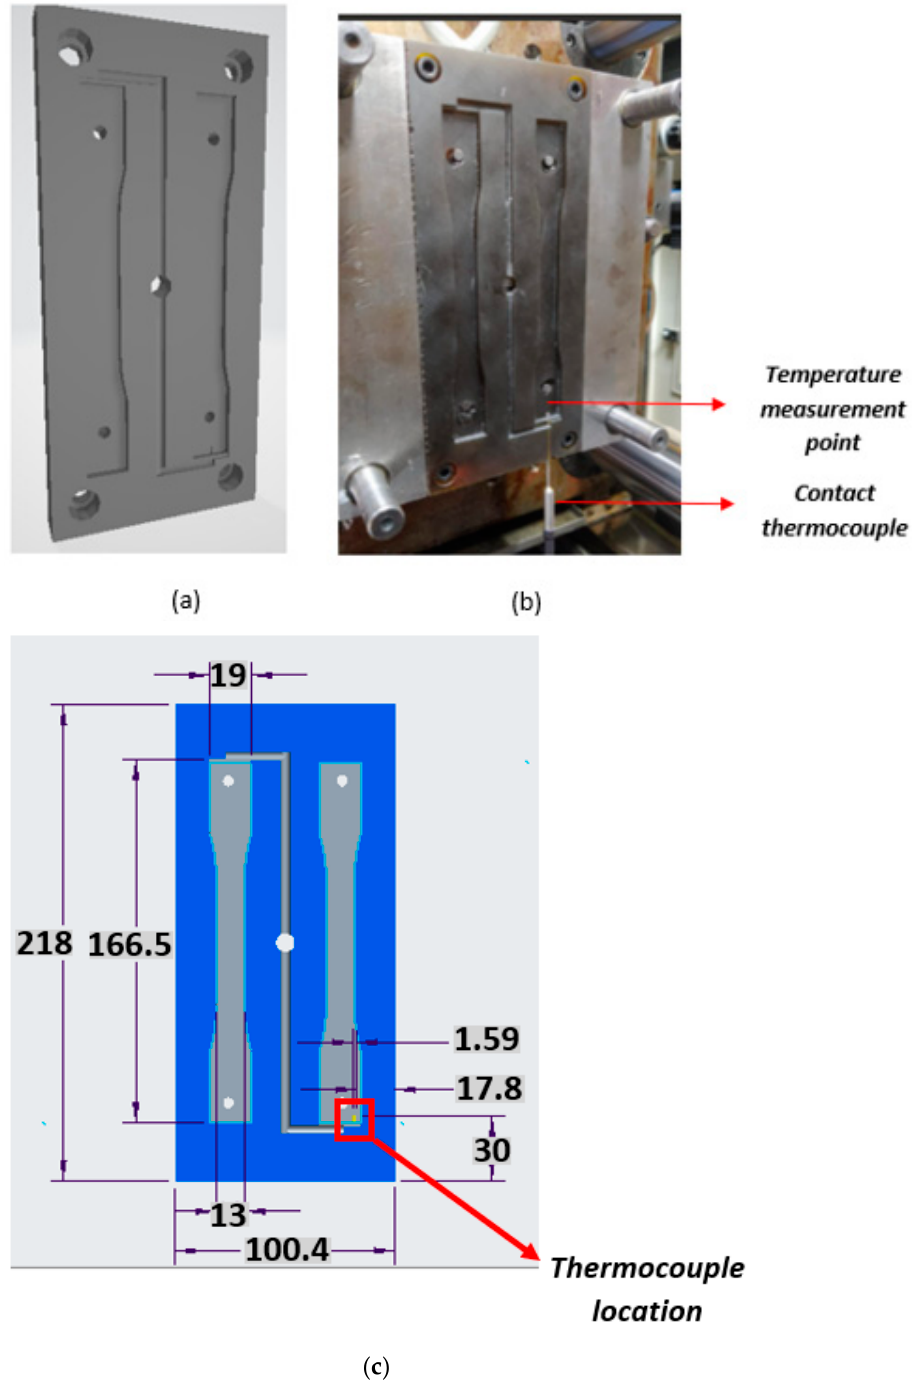
Figure 10. ( a ) CAD of rapid tooling mold for ASTM D638-compliant specimens. ( b ) Mold instrumented with a thermocouple to measure internal temperatures. ( c ) Thermocouple location and specimen measurements (in mm).